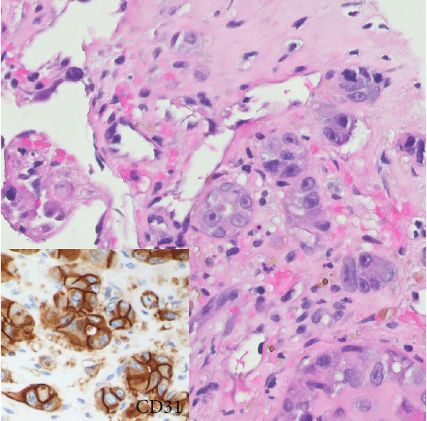
Figure 1: Microscopic examination, biopsy material. The conspic- uous clusters of malignant epithelioid cells dominate the picture and could give rise to a broad differential diagnosis that includes carcinoma and melanoma. The poorly formed vascular channels in the background could easily be overlooked. Immunohistochemistry was key (inset).